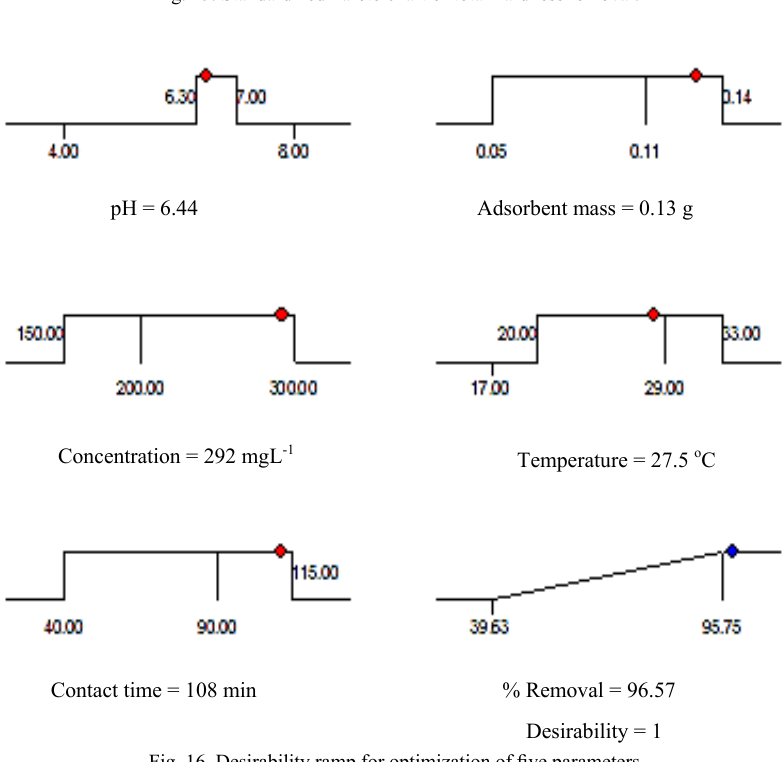
Fig. 16. Desirability ramp for optimization of five